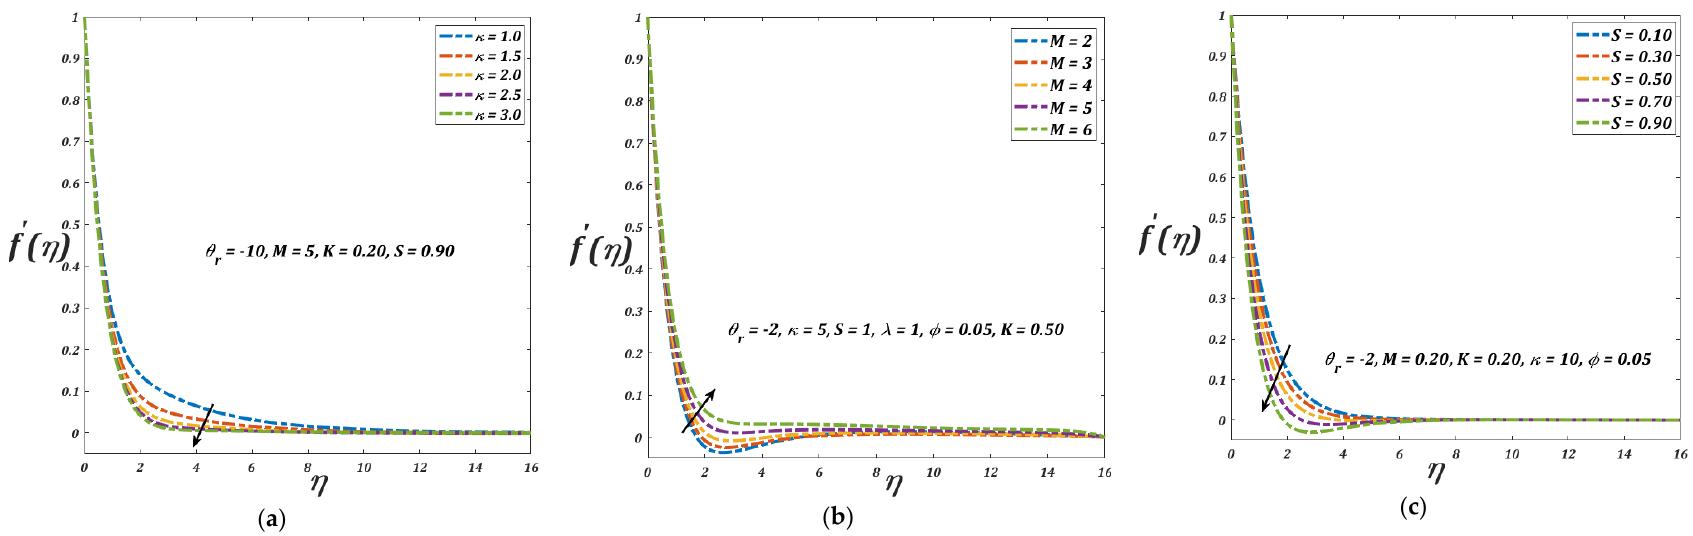
Figure 6. ( a ). Isotherm with S = 0.50. ( b ). Isotherm with S = 2.0. ( c ). Isotherm with S = 3.0.